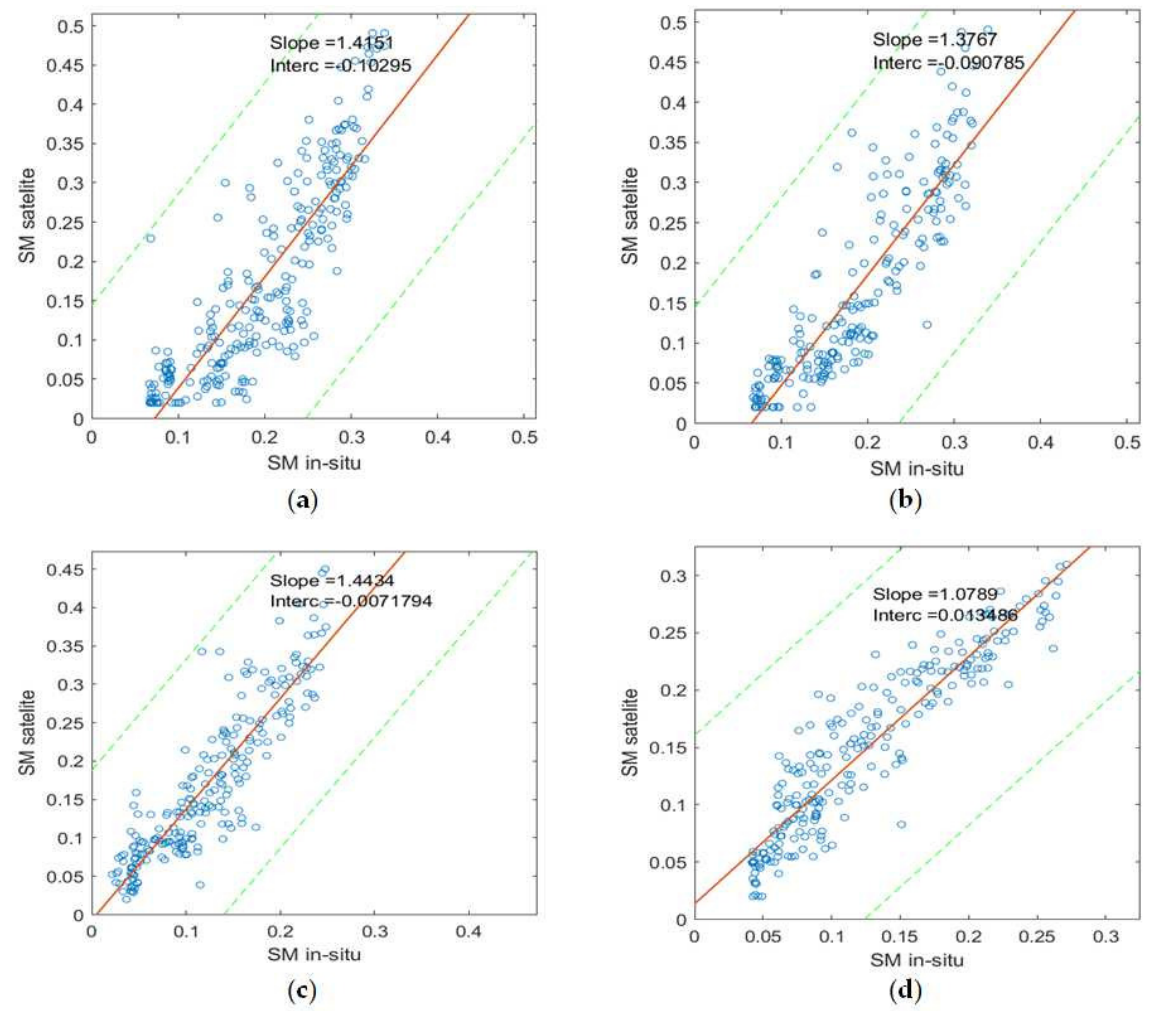
Figure 3. Scatterplots of stations-averaged soil moisture and SPL3SMP_36km soil moisture: ( a ) Grid_2139, ( b ) Grid_2140, ( c ) Grid_2141, and ( d ) Grid_2142. The green dashed lines represent the 95% confidence